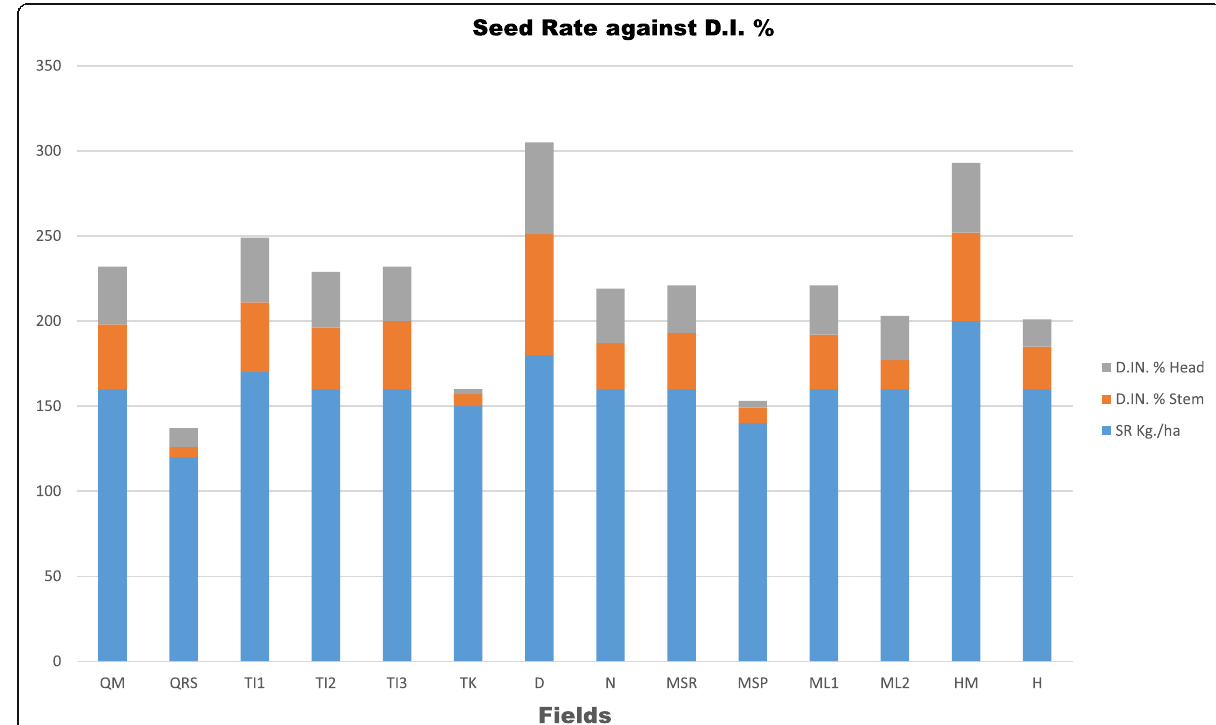
Fig. 3 The effect of seed rate with kilogram per hectare on disease incidence on the plant head and stem in the 14 selected wheat fields in the south of Iraq/Basra